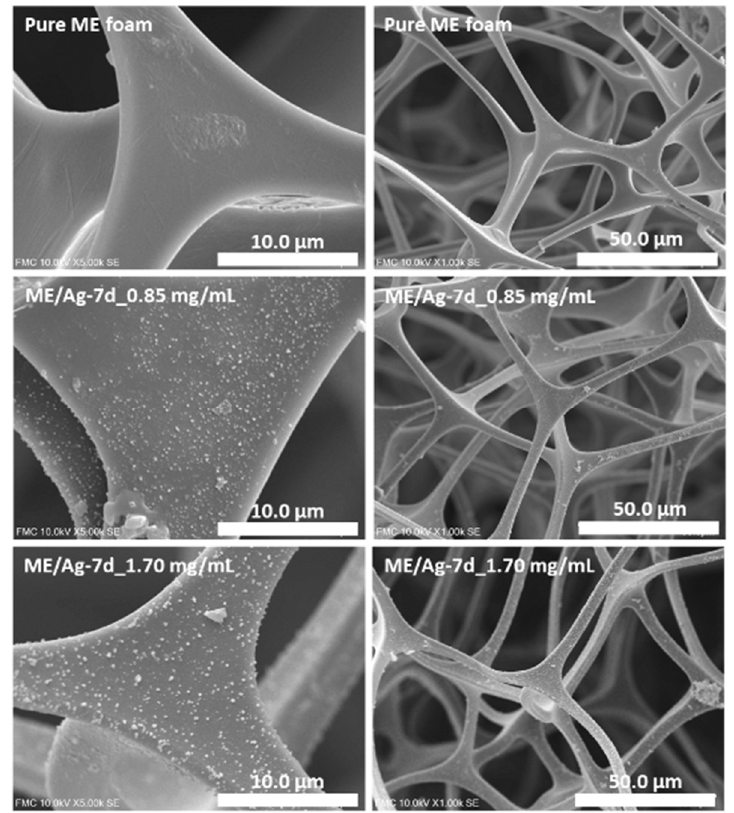
Figure 1. Scanning electron microscopy (SEM) micrographs of the untreated surface of melamine (ME) ( Pure ) and ME/Ag obtained after 7 day of reaction times using 0.85 and 1.70 mg/mL as precursor solution, showing a homogeneous distribution of the AgNPs along the strut in both lower and high